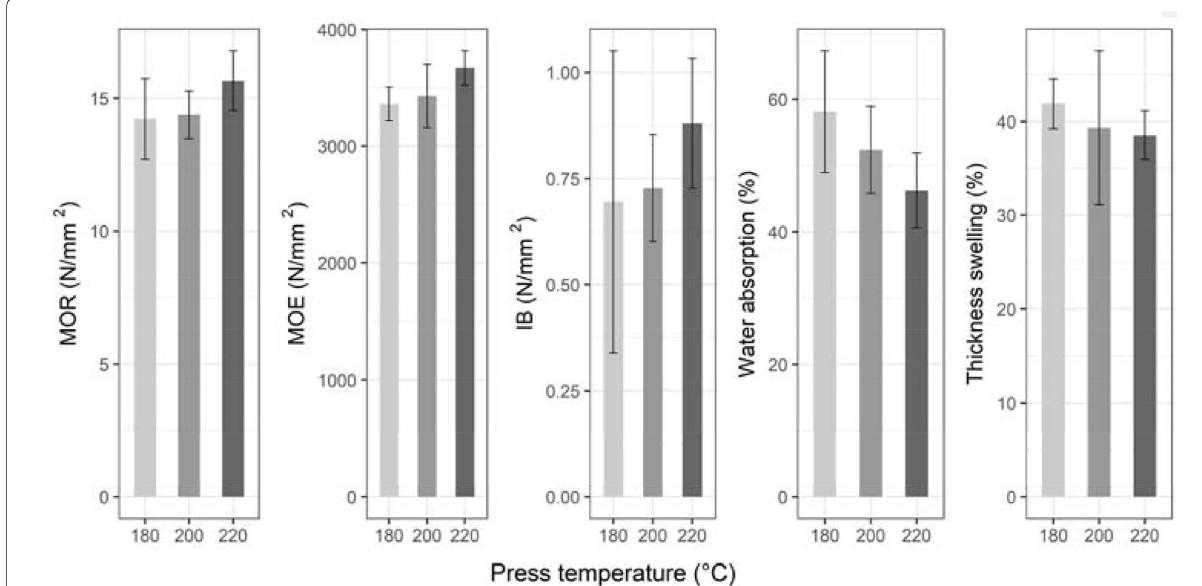
Fig. 1 Dimensional stability and mechanical properties of jute stick binderless particleboard (JBPB) as a function of press temperatures. Error bar indicates the standard